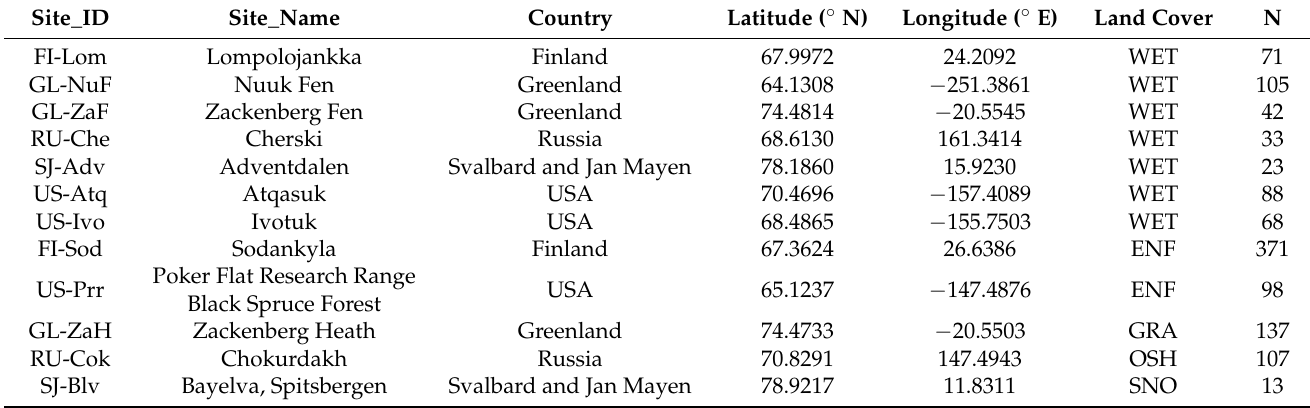
Figure 1. ( a ) Location of the FLUXNET sites used in this study. The description of these sites is provided in Table 1. The base map is the land cover types of the Arctic. ( b ) The elevation distribution of the Arctic. Table 1. Basic information regarding the FLUXNET sites of the